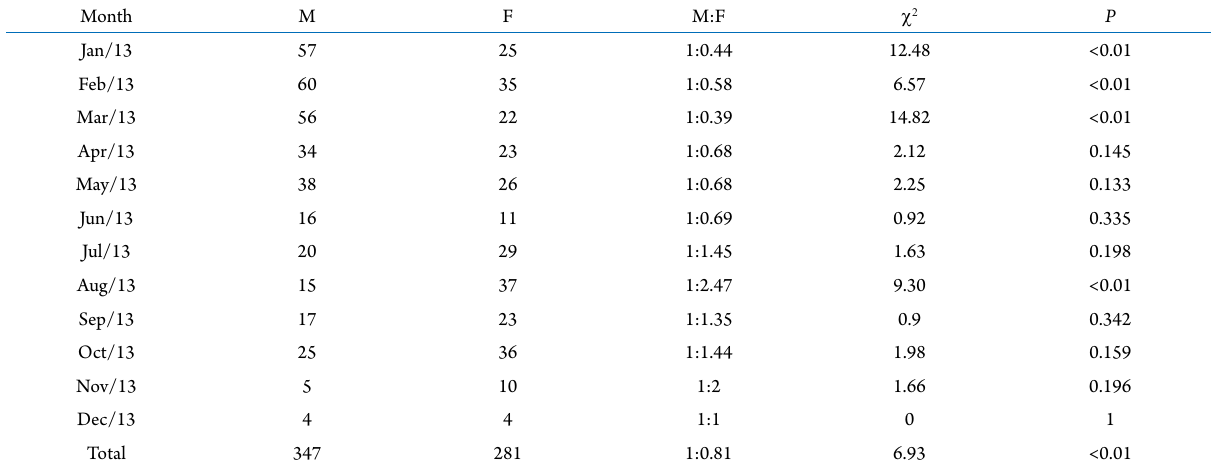
Figure 2. Macrobrachium jelskii (Miers, 1877). Values of temperature, rainfall and absolute frequency of juvenile males (JM), adult males (AM), juvenile females (JF), non-ovigerous females (NOF) and ovigerous females (OF) throughout the study period. Table 1. Macrobrachium jelskii (Miers, 1877). Sampling and total number of males (M), females (F) and sex ratio (M:F), with Chi- square values (χ 2 ) and probability ( P